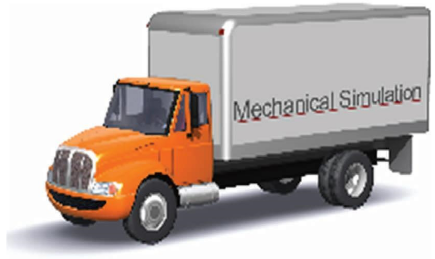
Figure 6: Two-axle